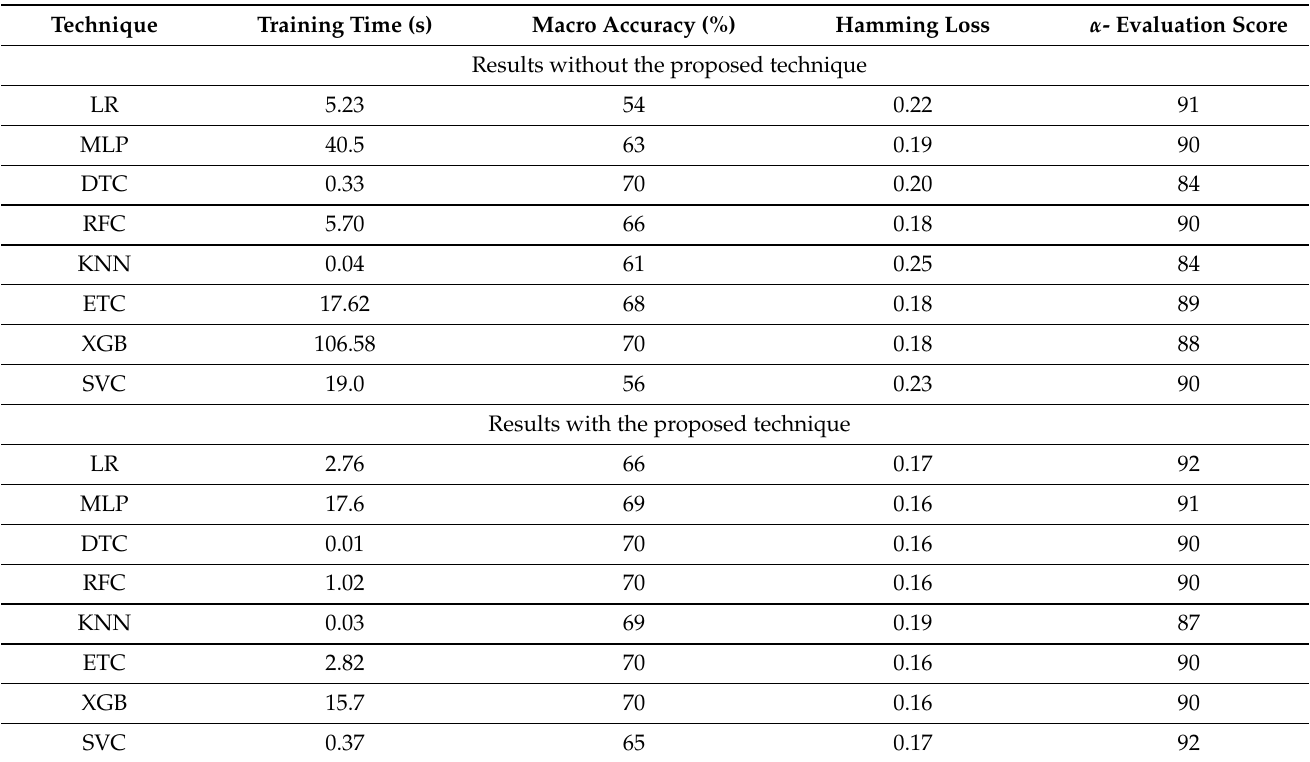
Table 11. The multi-label multi-class performance comparative analysis using a data split of